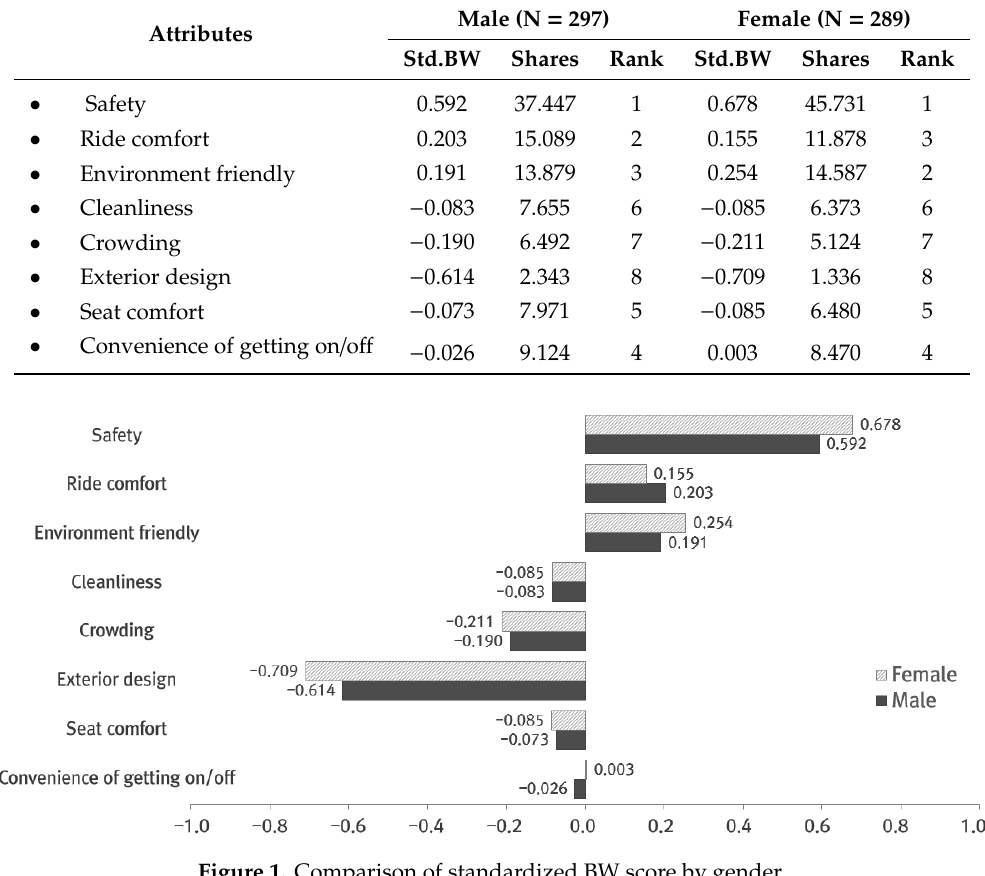
Table 7. Comparison of best-worst scaling scores by gender.